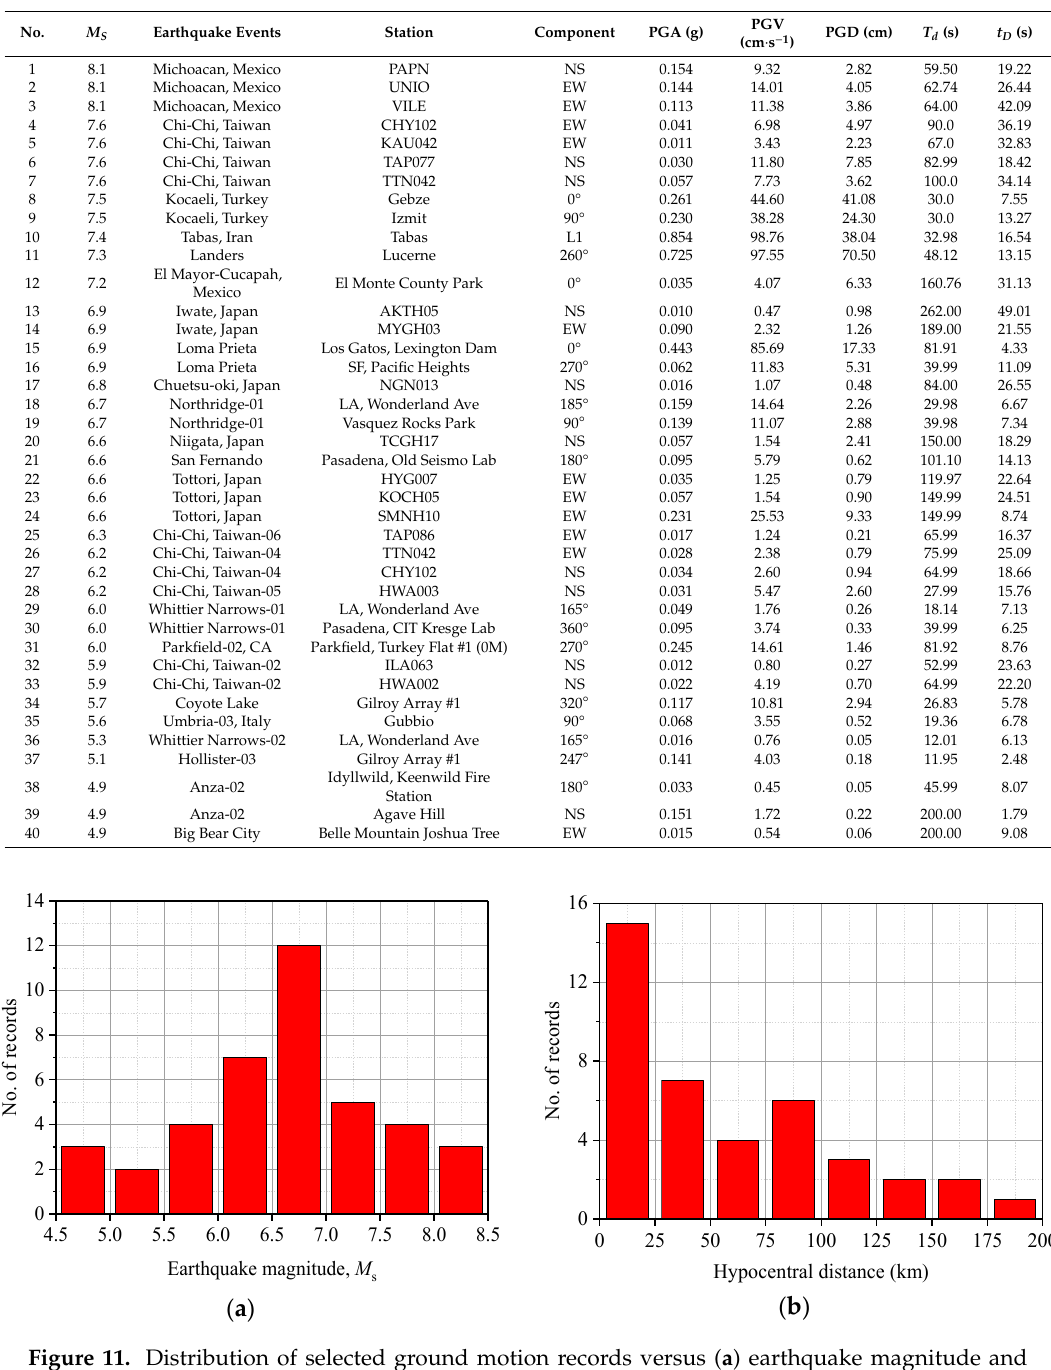
Table 4. Selected ground motion records and some of their characteristics. PGA, peak ground acceleration; PGV, peak ground velocity; PGD, peak ground displacement. T d : total duration; t D : strong motion duration.